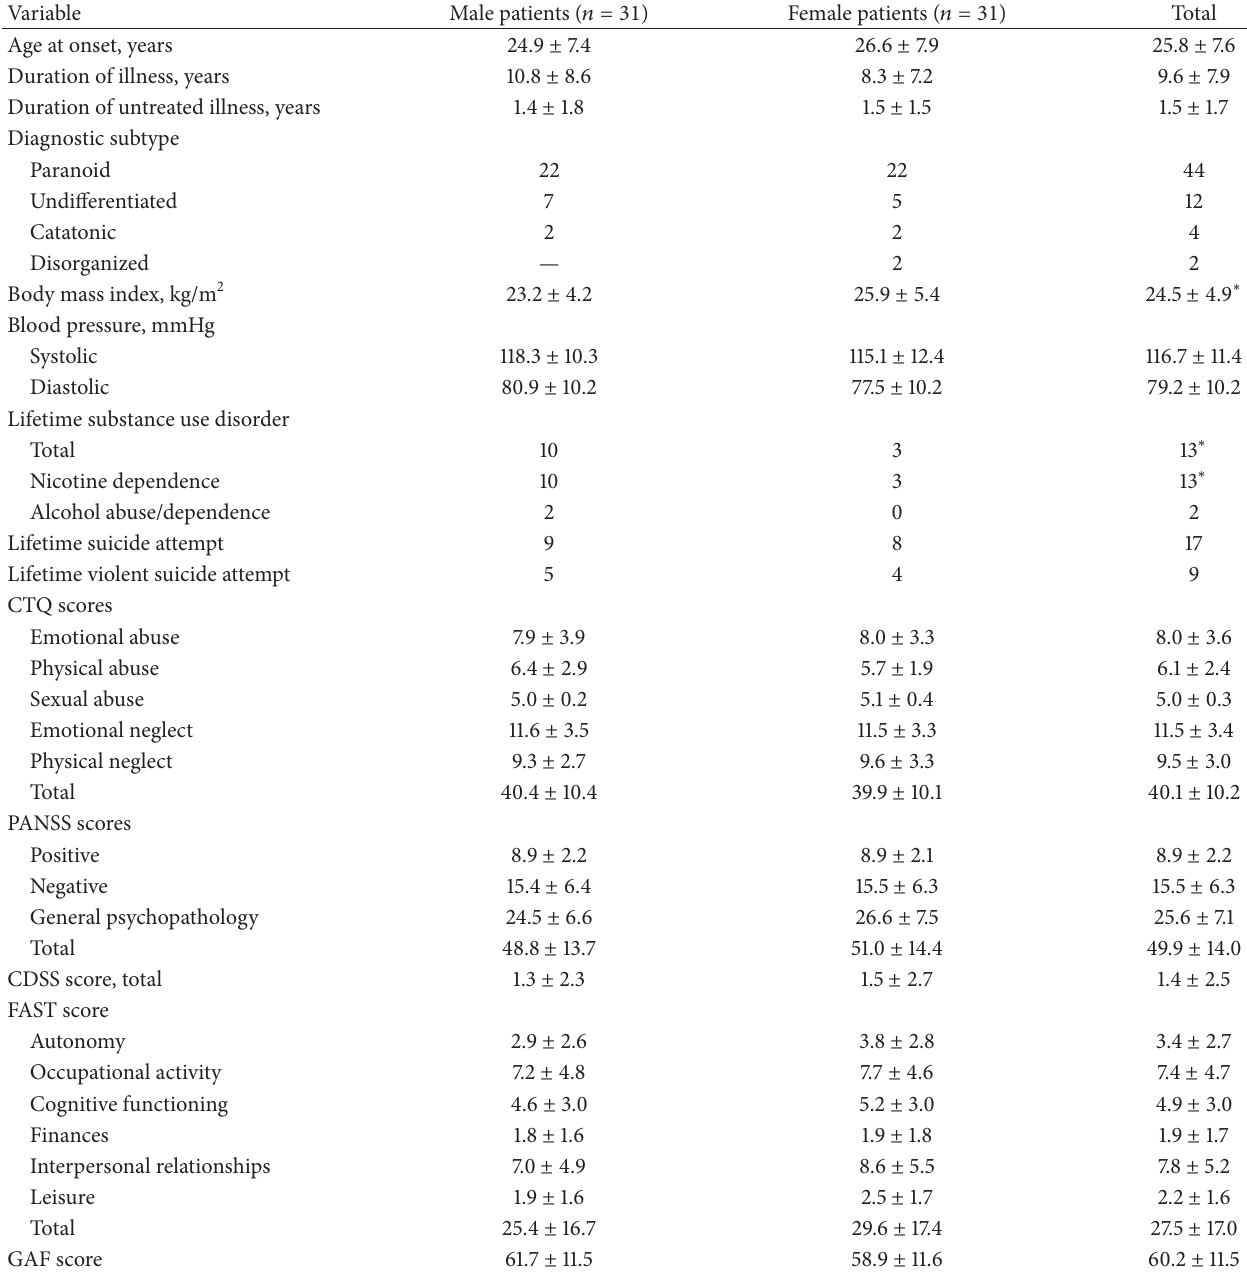
Table 1: Clinical description of the sample by